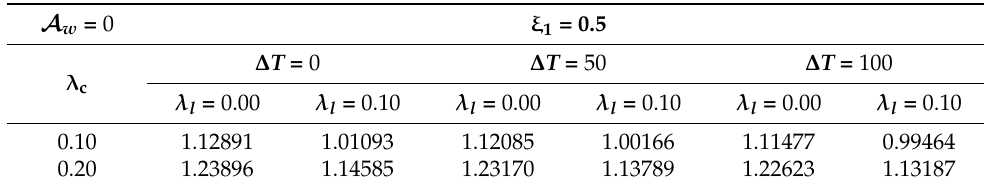
Table 7. Linear dimensionless natural frequencies of porous FG clamped–clamped (C–C) nano-beam for ξ 1 = 0.5.